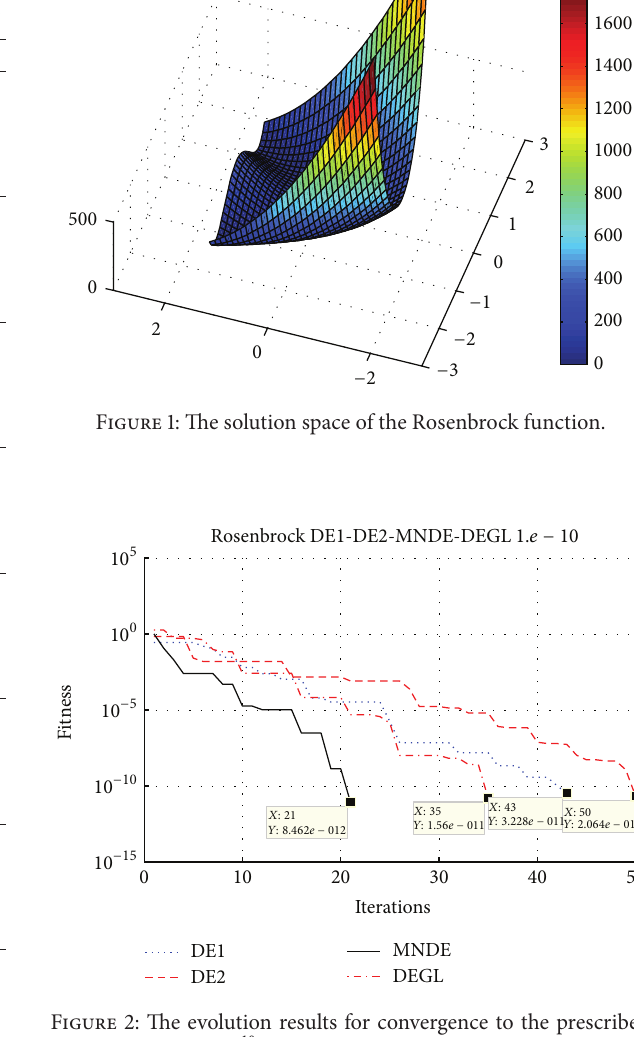
Figure 2: The evolution results for convergence to the prescribed threshold fitness ( 10 −10 ).